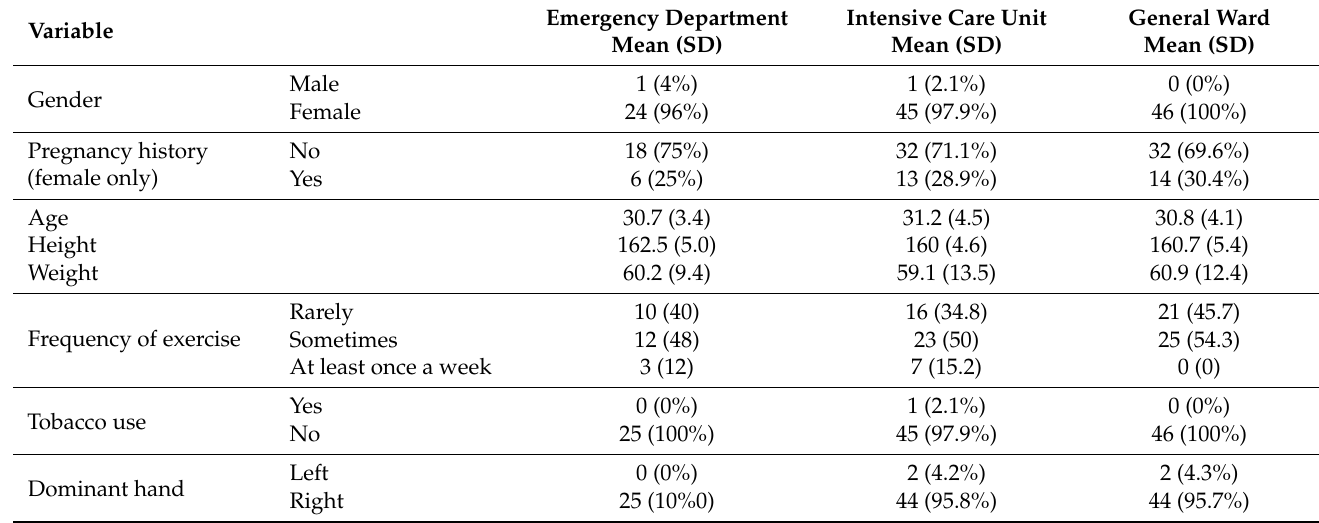
Table 1. Health and lifestyle characteristics of nursing